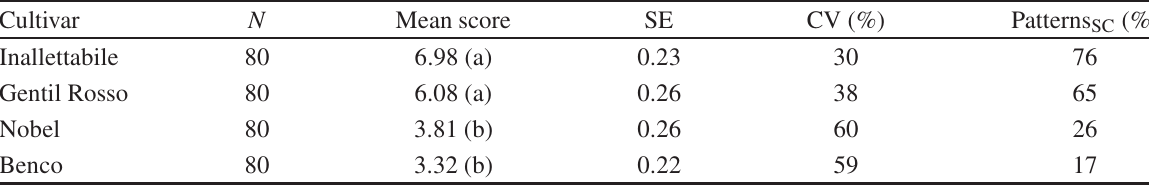
TABLE 1: Visual assessment of images from different wheat cultivars: mean score, coefficient of variation (CV), and percentage of patterns with a single crystallization core (Patterns SC ). Different letters indicate significant differences at P < 0 . 05